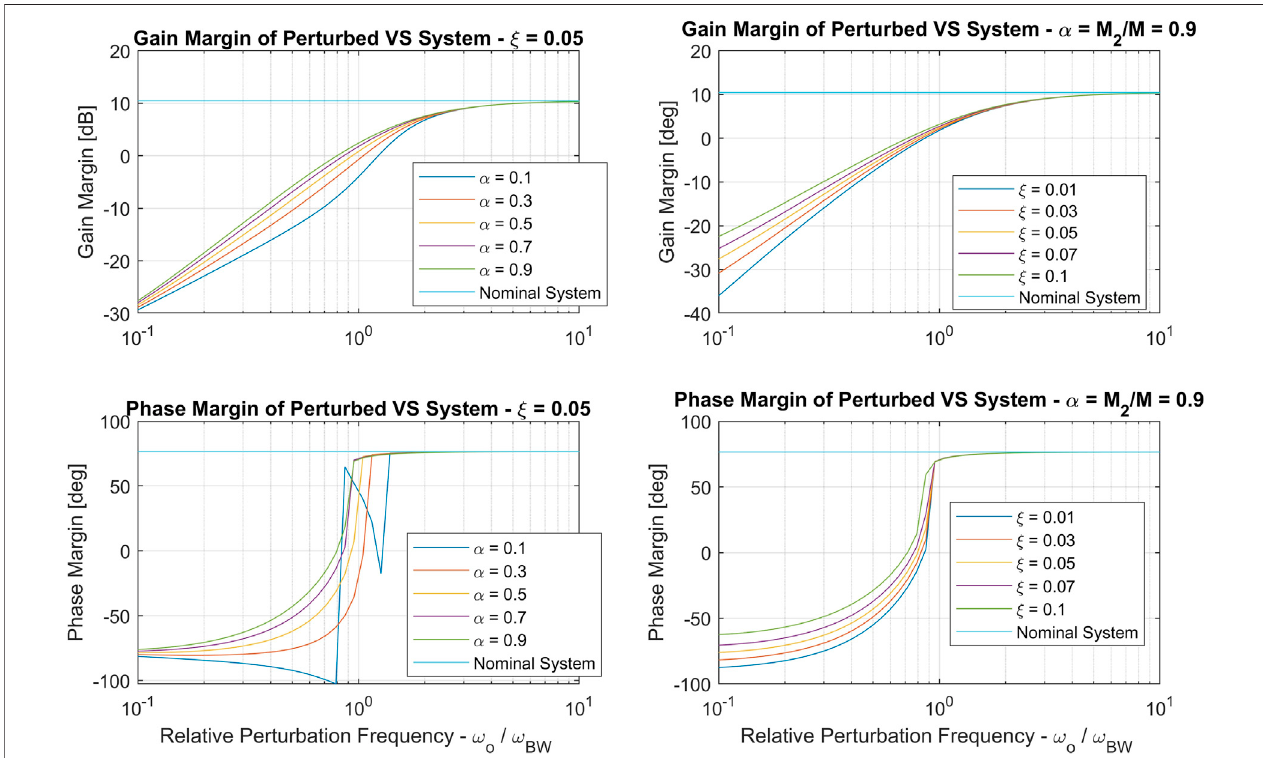
FIGURE11| Gainmargins (toprow) andphasemargins (bottomrow) forvision-basedservoingloop.Theleftcolumndemonstratestheeffectofchanginginertia fraction α and the right column demonstrates the effect of perturbation damping ξ .